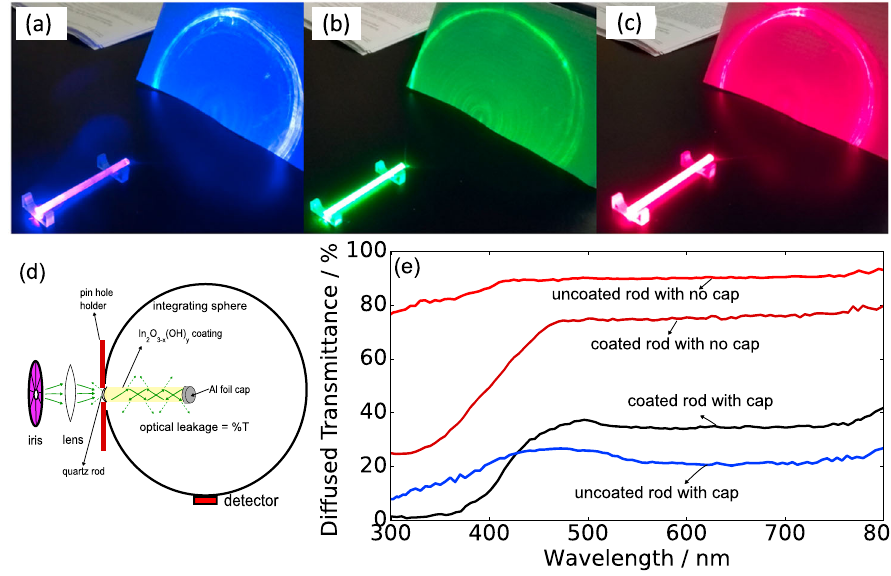
Fig. 3 Spectral waveguiding. Waveguiding of blue ( a ), green ( b ), and red ( c ) laser illumination at an angle of incidence of 60°. d The integrating sphere measurement of the optical leakage through an In 2 O 3 − x (OH) y coated cylindrical quartz rod waveguide, with e showing the optical leakage spectra through the sides (along the length) of a coated and uncoated cylindrical rod